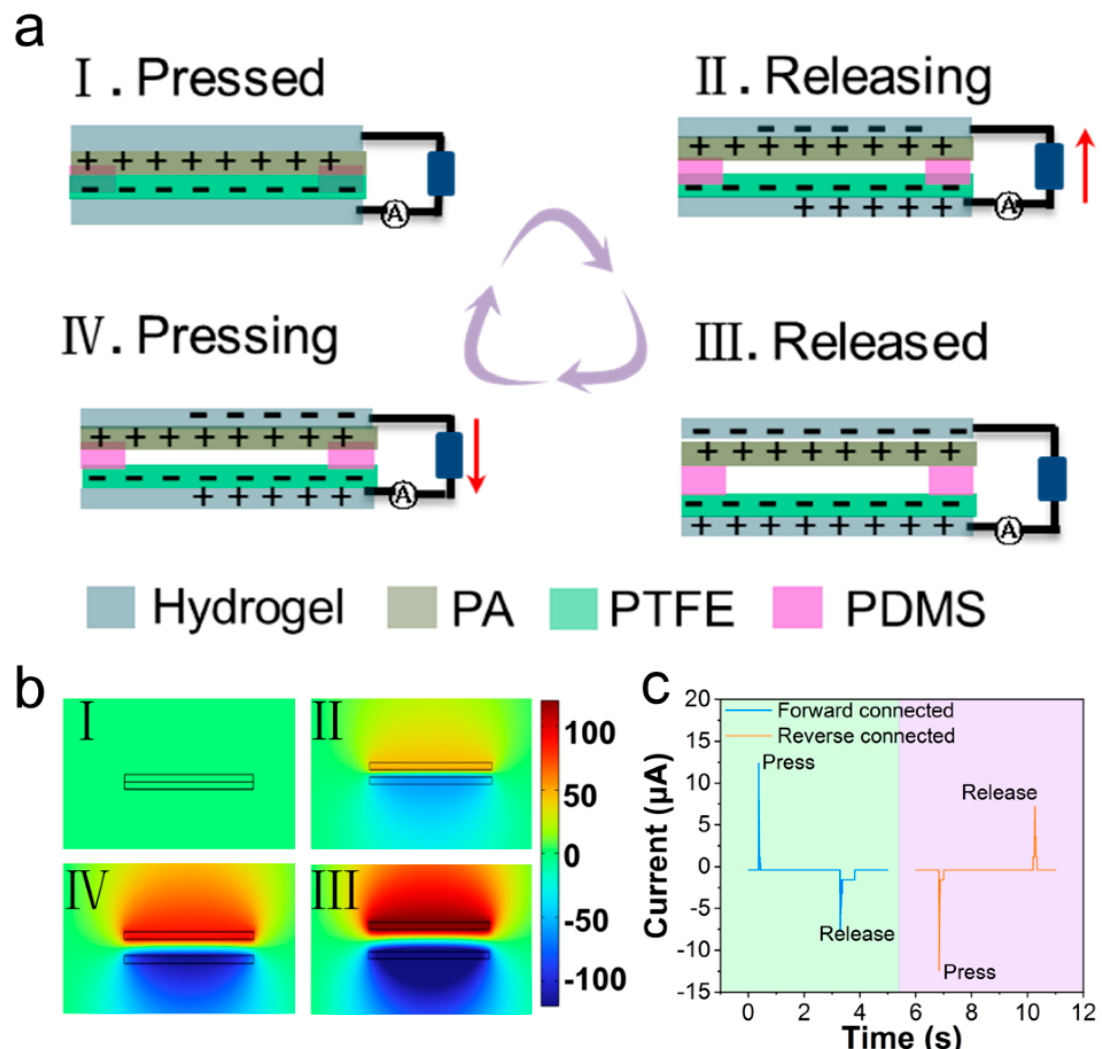
Figure 2. The SD-TENG mechanism. ( a ) Schematics of the operating principle of the SD-TENG. ( b ) COMSOL simulations were performed to clarify SD-TENG’s working principle. ( c ) Switching polarity test of SD-TENG.